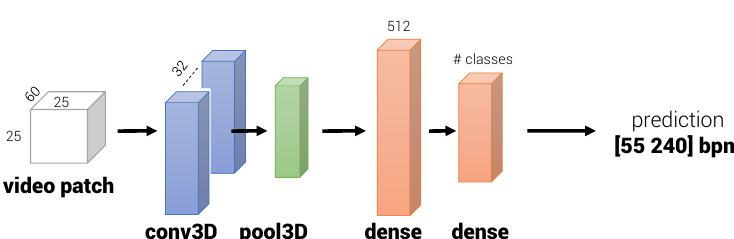
Figure 6. Model architecture. The network integrates a 3D convolution (blue) with its associated 3D pooling (green) layers. The stream converges to two fully dense layers (orange).